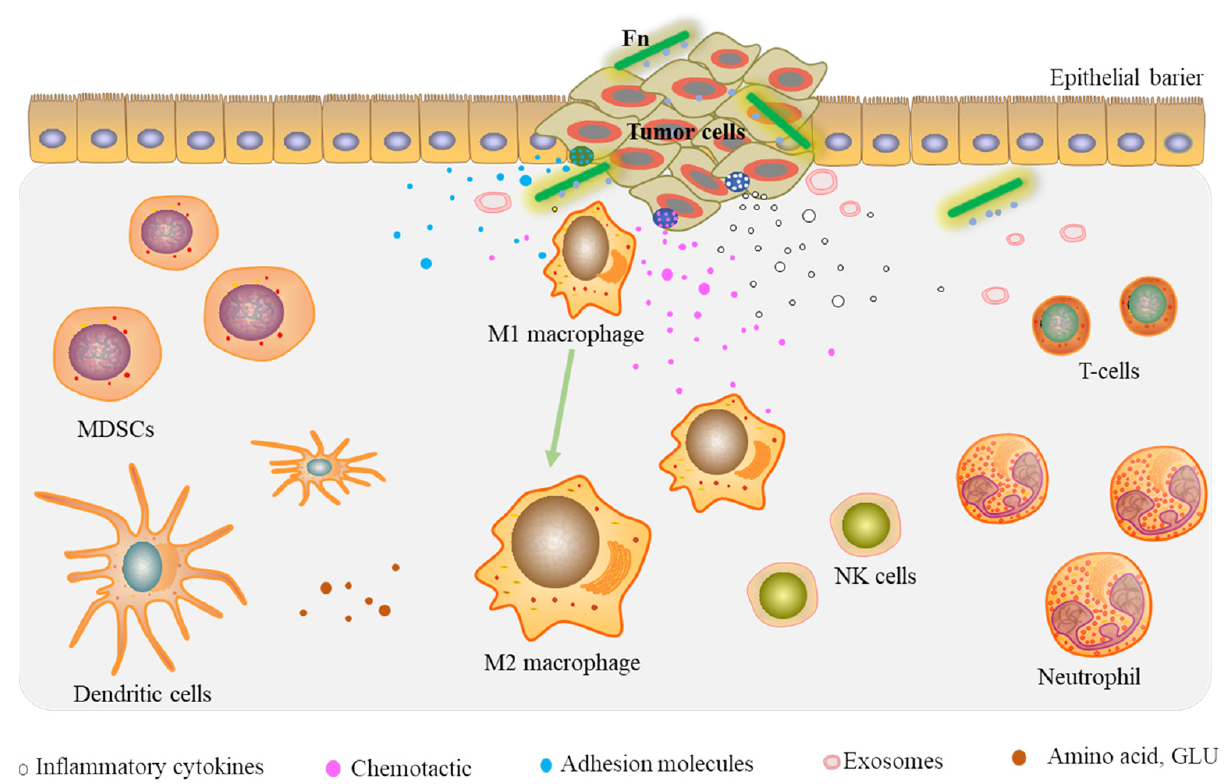
Figure Figure 2. Fn reprograms the TME by recruiting tumor-infiltrating immune cells and prometastatic cytokines.